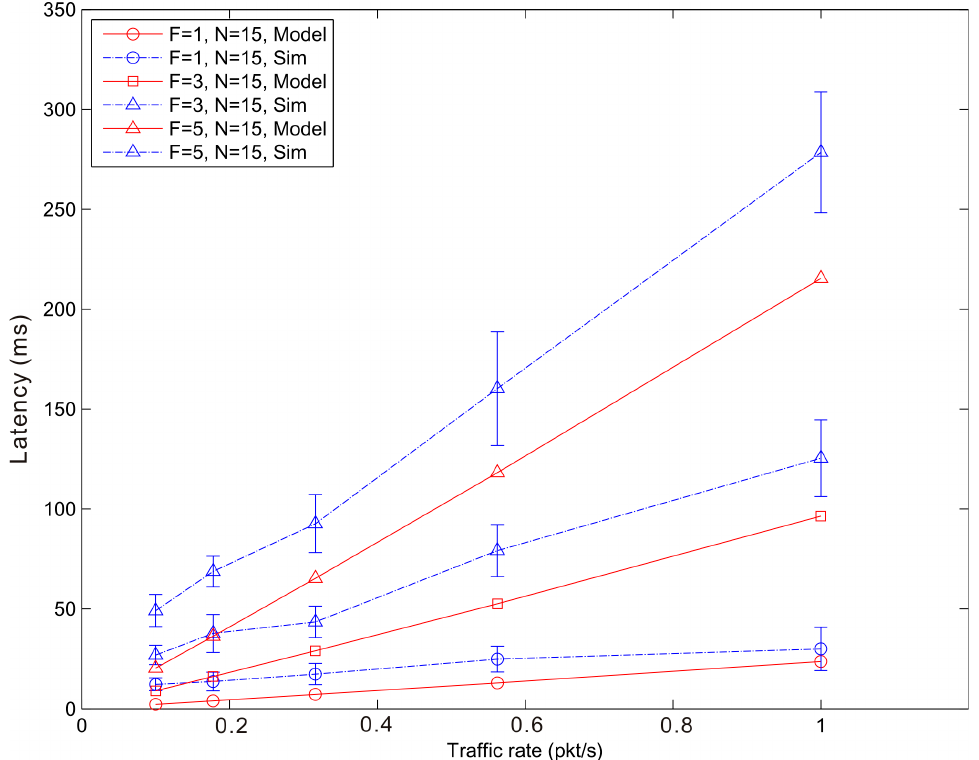
Figure 18. 6LoWPAN Fragmentation Latency versus traffic rate for a star topology network composed by 15 nodes.